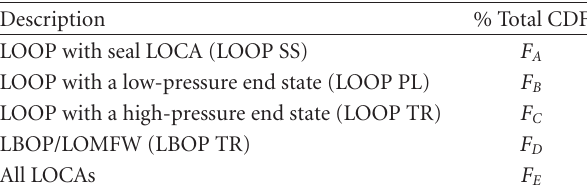
Table 4: Relevant core damage events and